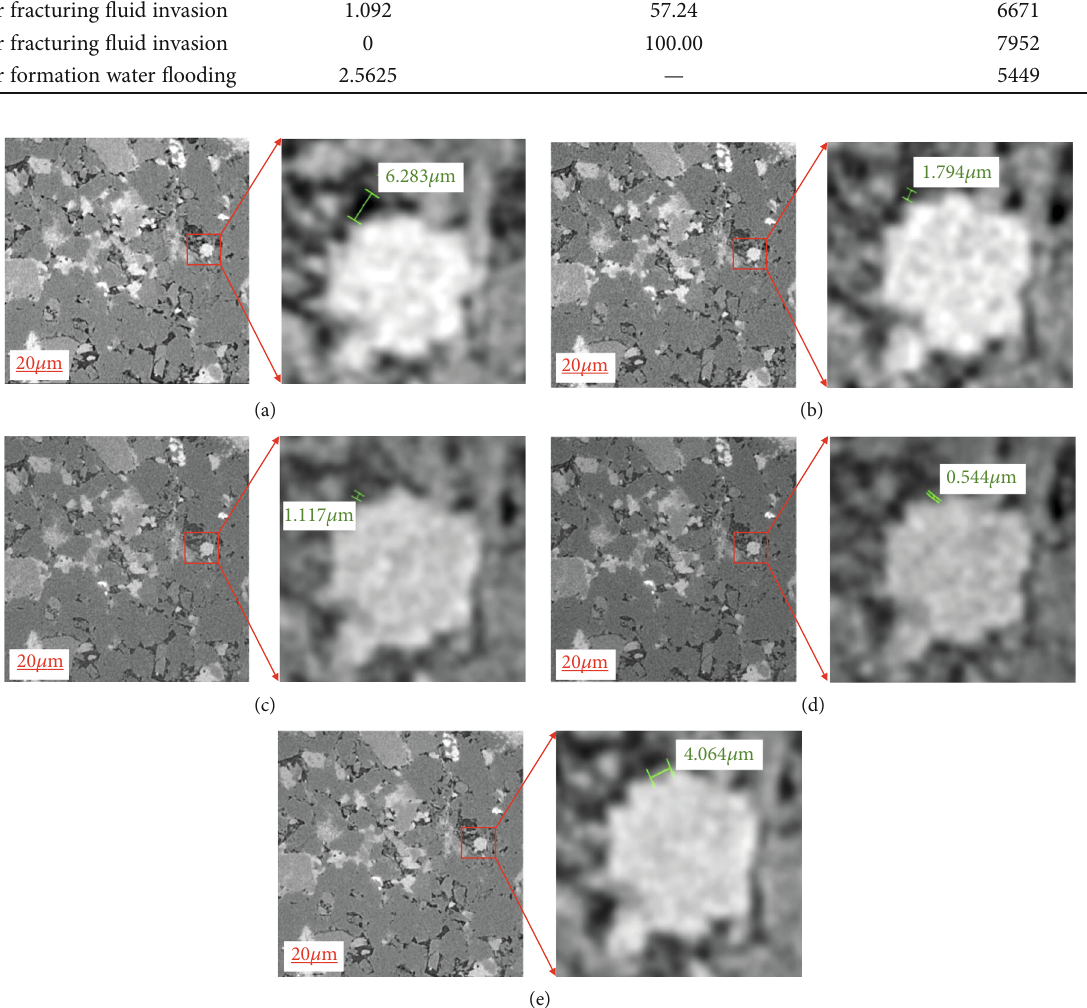
Figure 5: Size changes of typical micropores in di ff erent stages (Note: (a) snapshot following saturation with formation water; (b) 9h after fracturing fl uid invasion; (c) 24h after fracturing fl uid invasion; (d) 72 h after fracturing fl uid invasion; (e) 24h after subsequent water fl ooding).